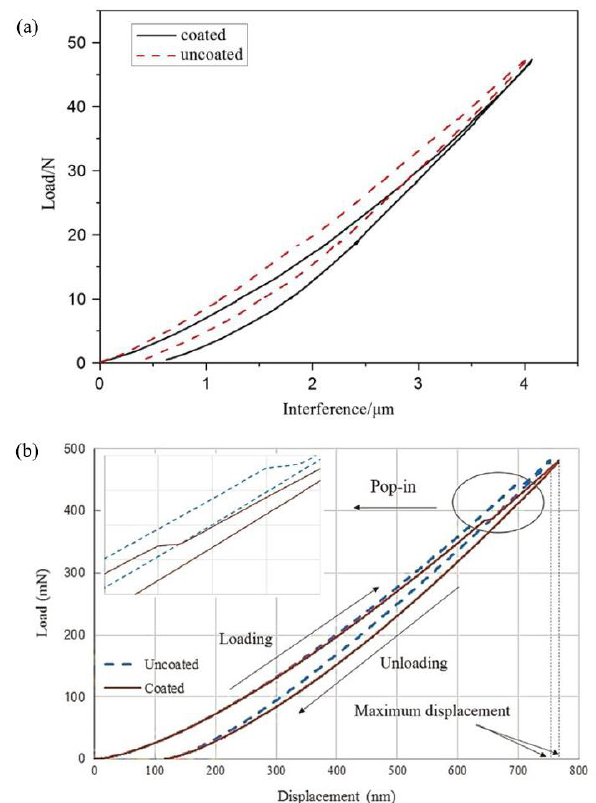
Figure 8. ( a ) Typical load–interference relation obtained from flattening of a coated and an uncoated sphere (taken from [56]) and ( b ) typical load–displacement relation obtained from the indentation of coated and uncoated silicon flat (taken from [57]).